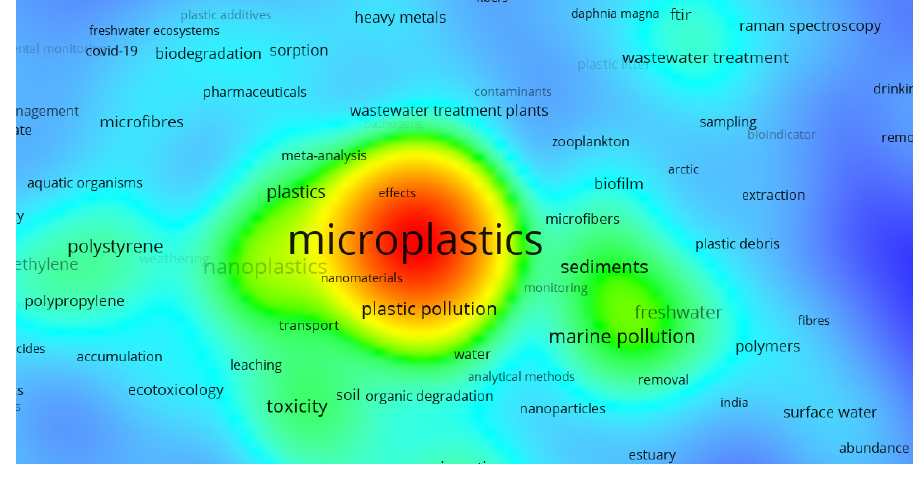
Figure 2. Density visualization of the co-occurrence map of the KWs used in the articles derived from query Q1, with a minimum occurrence of 5. The results have been divided in 4 groups, de- pending on the publication year of the related articles.